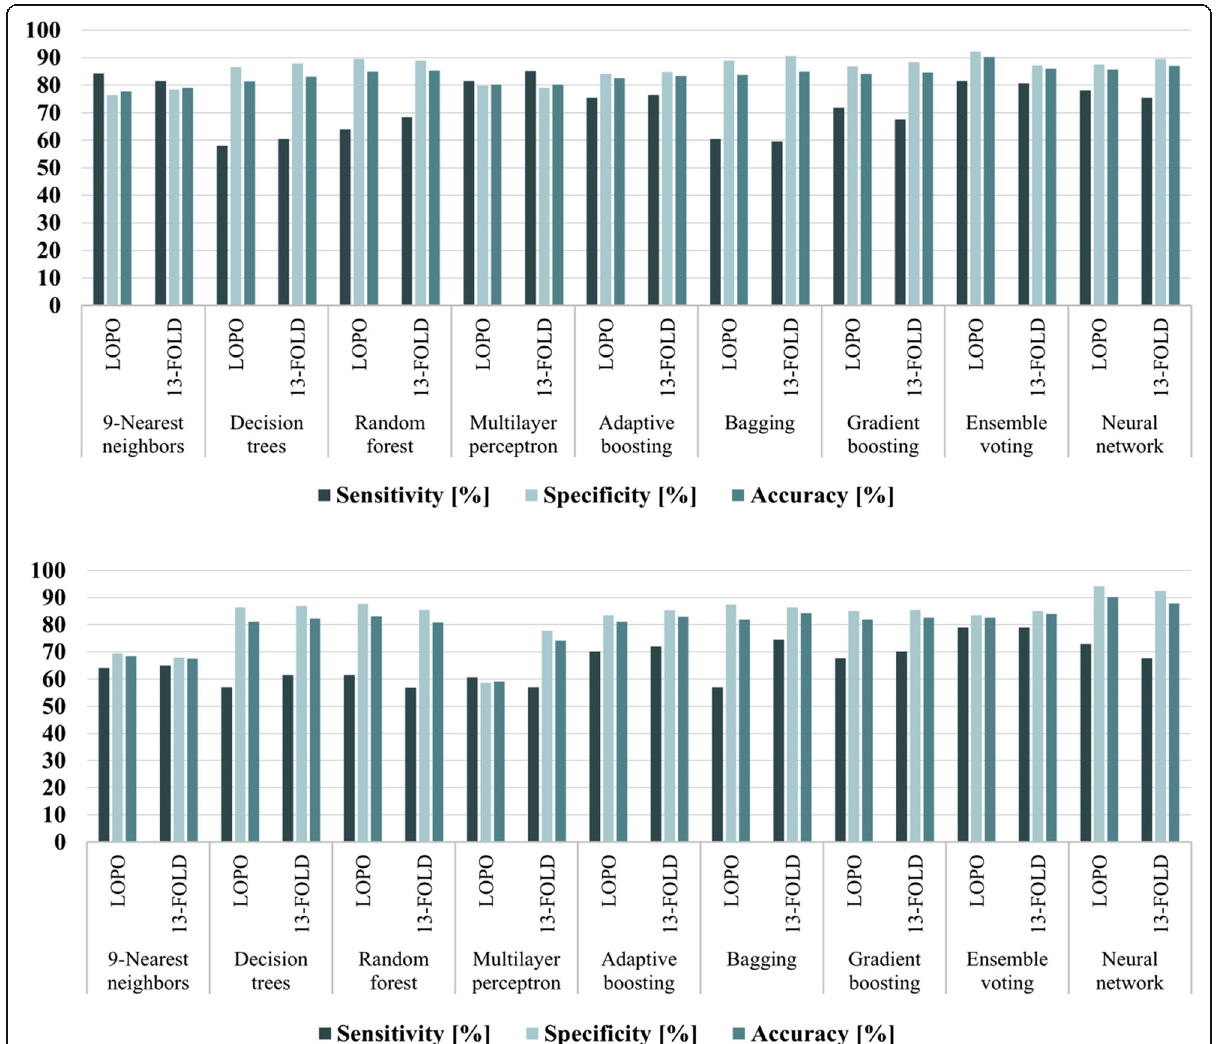
Fig. 6 Classification results of the true microcalcifications as BI-RADS benign or suspicious using different classifiers and cross-validation methods. up Results using temporal subtraction of mammograms. down Results using only the most recent mammograms. LOPO